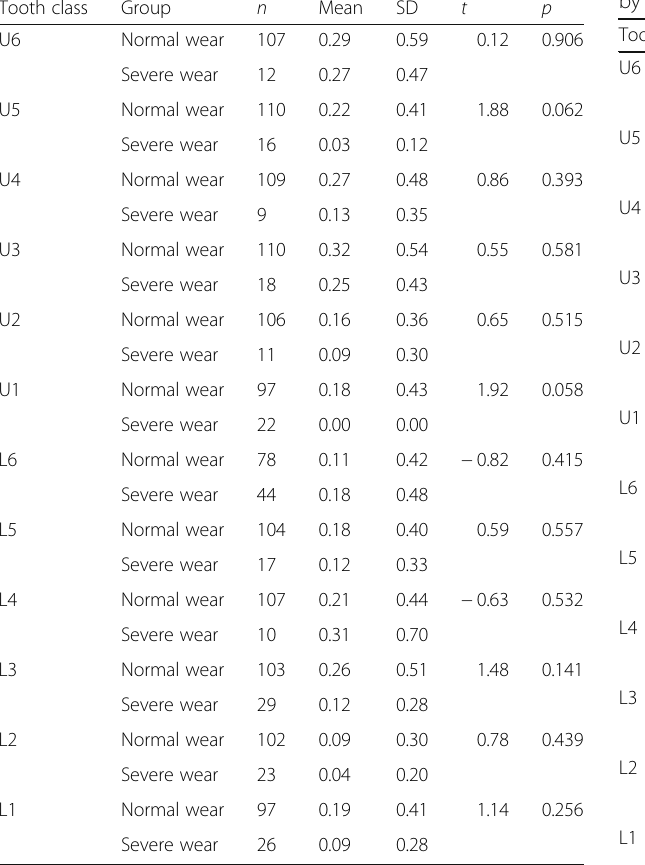
Table 5 Independent t -tests comparing the measure of clinical recession in the normal wear and severe wear subsets